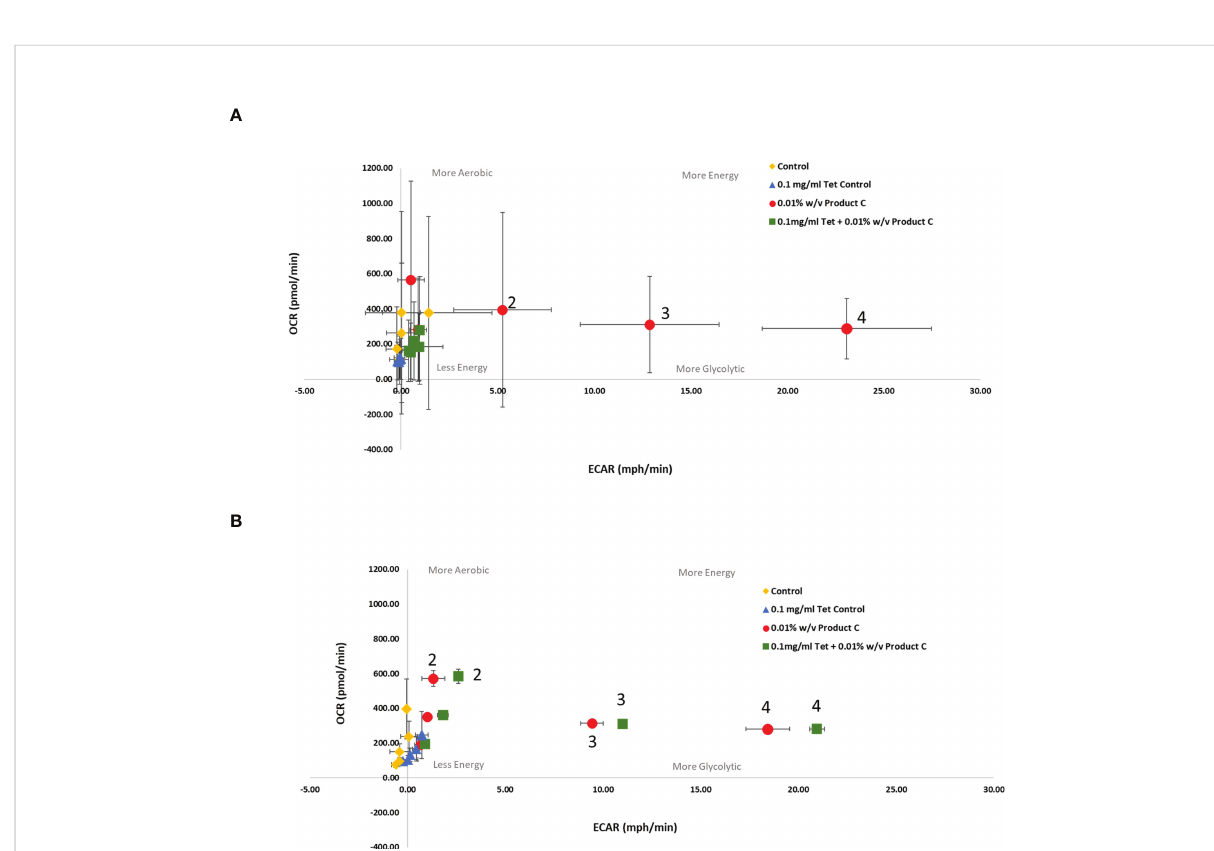
FIGURE 4 Bioenergetic real time changes in OCR/ECAR ratio of (A) antibiotic susceptible E. coli and (B) antibiotic resistant E. coli when treated with YPPC. Numbered data points represent the following time-points (0) 14 mins (1) 52 mins (2) 98 mins (3) 149 mins (4) 201 mins. Several data points have been labelled with their representative time-points for ease of results visibility. Each value was expressed using mean of triplicates for each biological replicate (n=3), error bars are representative of standard deviation. Control refers to no product/tetracycline supplementation. Product C =